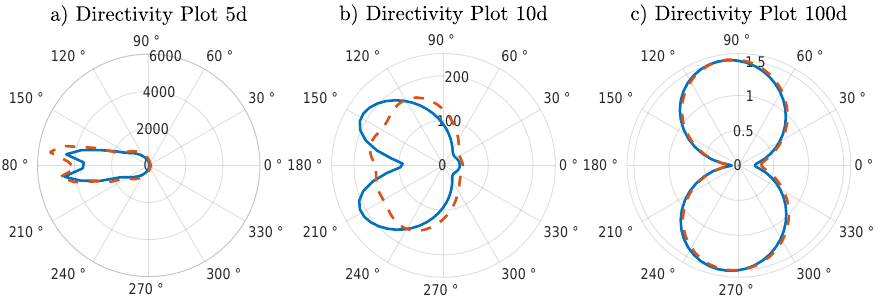
Figure 14. Directivity plot of the p rms [Pa] determined by the solution of the FW-H equation on points placed on concentric circles at ( a ) r = 5 d , ( b ) r = 10 d and ( c ) r = 100 d . Solid line, rigid cylinder; dashed line, flexible cylinder.